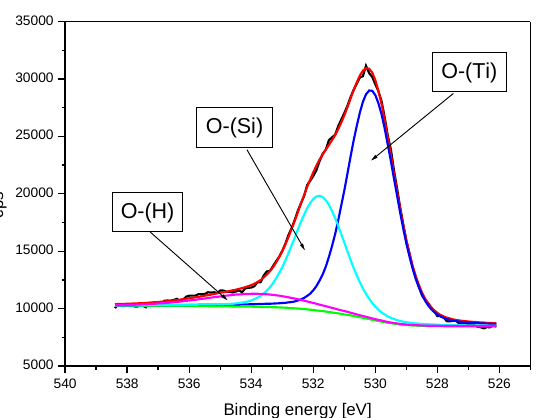
Figure 6. High resolution XPS spectra of titanium Ti2p region of Figure 5. HighresolutionXPSspectraofoxygenO1sregionofST12 ST12 sample Fig.5. High resolution XPS spectra of oxygen O1s region of ST12 sample sample Fig.6. High resolution XPS spectra of titanium Ti2p region of ST12 sample Fig.6. High resolution XPS spectra of titanium Ti2p region of ST12 sample